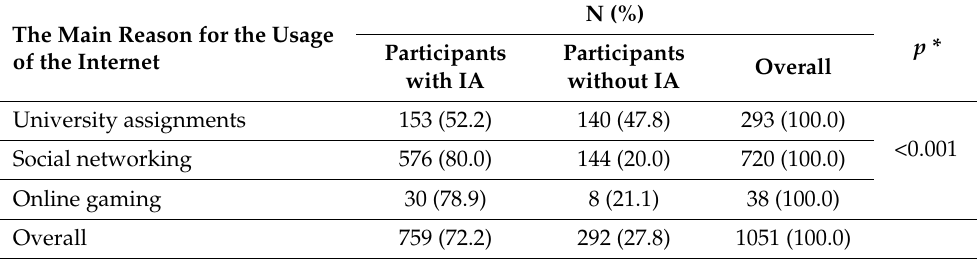
Table 3. Participants with or without IA according to the main reason for the usage of the Internet.